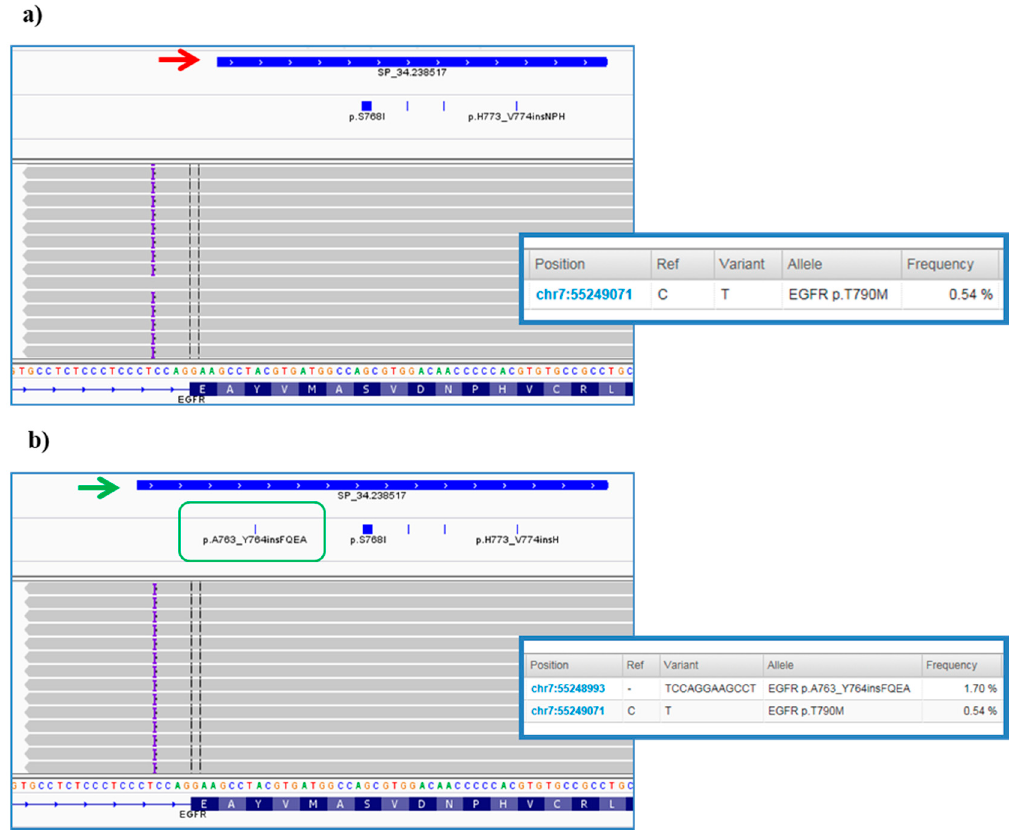
Figure 7. Integrative Genomics Viewer (IGV) screenshots of Ala763_Tyr764insPheGlnGluAla variant in EGFR gene. (a) The figure shows the complex InDel in exon 20 of the EGFR gene found at first by visualization with the IGV software. This is a rare insertion of 12 bp (purple braces) mapped outside the of the exon 20 not initially covered by the designed amplicon and consequently not called by the Torrent Variant Caller (TVC, red arrow). (b) The panel below depicts the results of the analysis after some bioinformatics changes to TVC parameters. As it can be noted, the blue bar of the amplicon was elongated to also cover the genomic position at the end of the intron where the mutation occurs (green arrow). Consequently, the hotspot Browser Extensible Data (BED) file was modified (green box) and the specific insertion was correctly reported in the TVC section of the TSS (screens on the right).